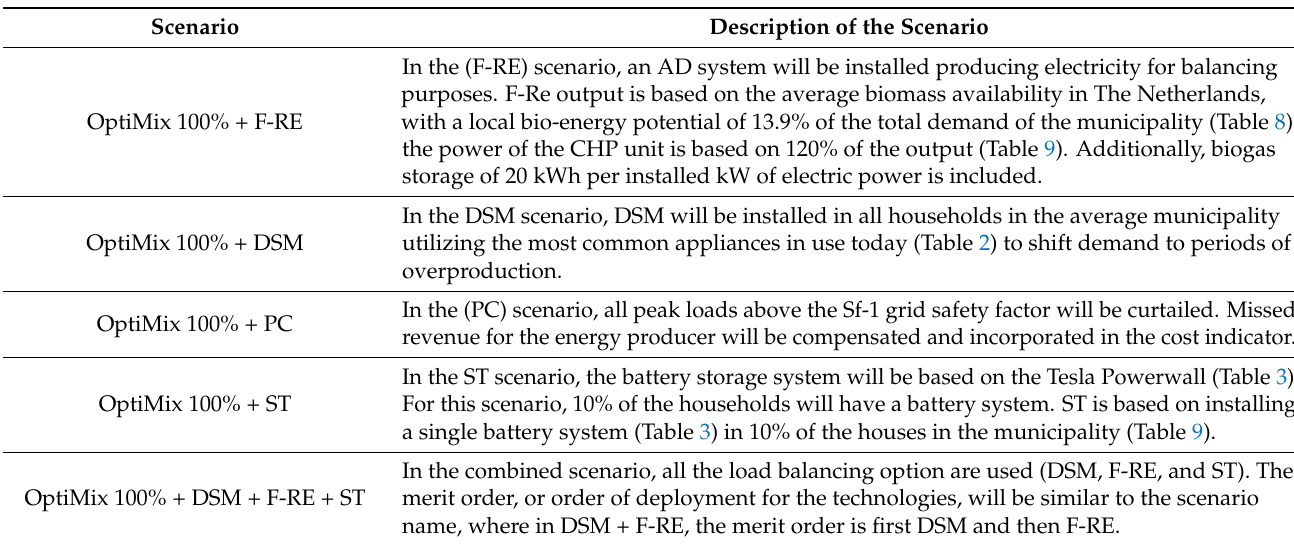
Table 7. The Balancing Technology Scenarios.